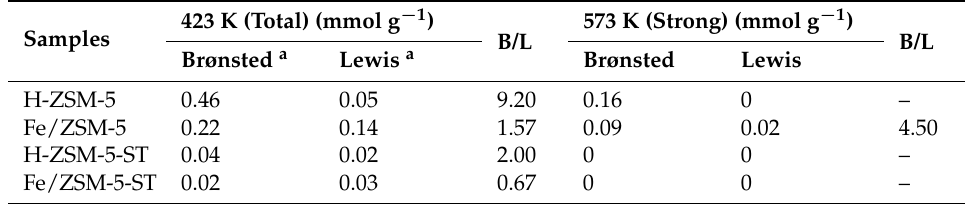
Table 4. Acidity properties from the Py-FTIR analysis for catalysts H-ZSM-5, Fe/ZSM-5, H-ZSM-5-ST and Fe/ZSM-5-ST.